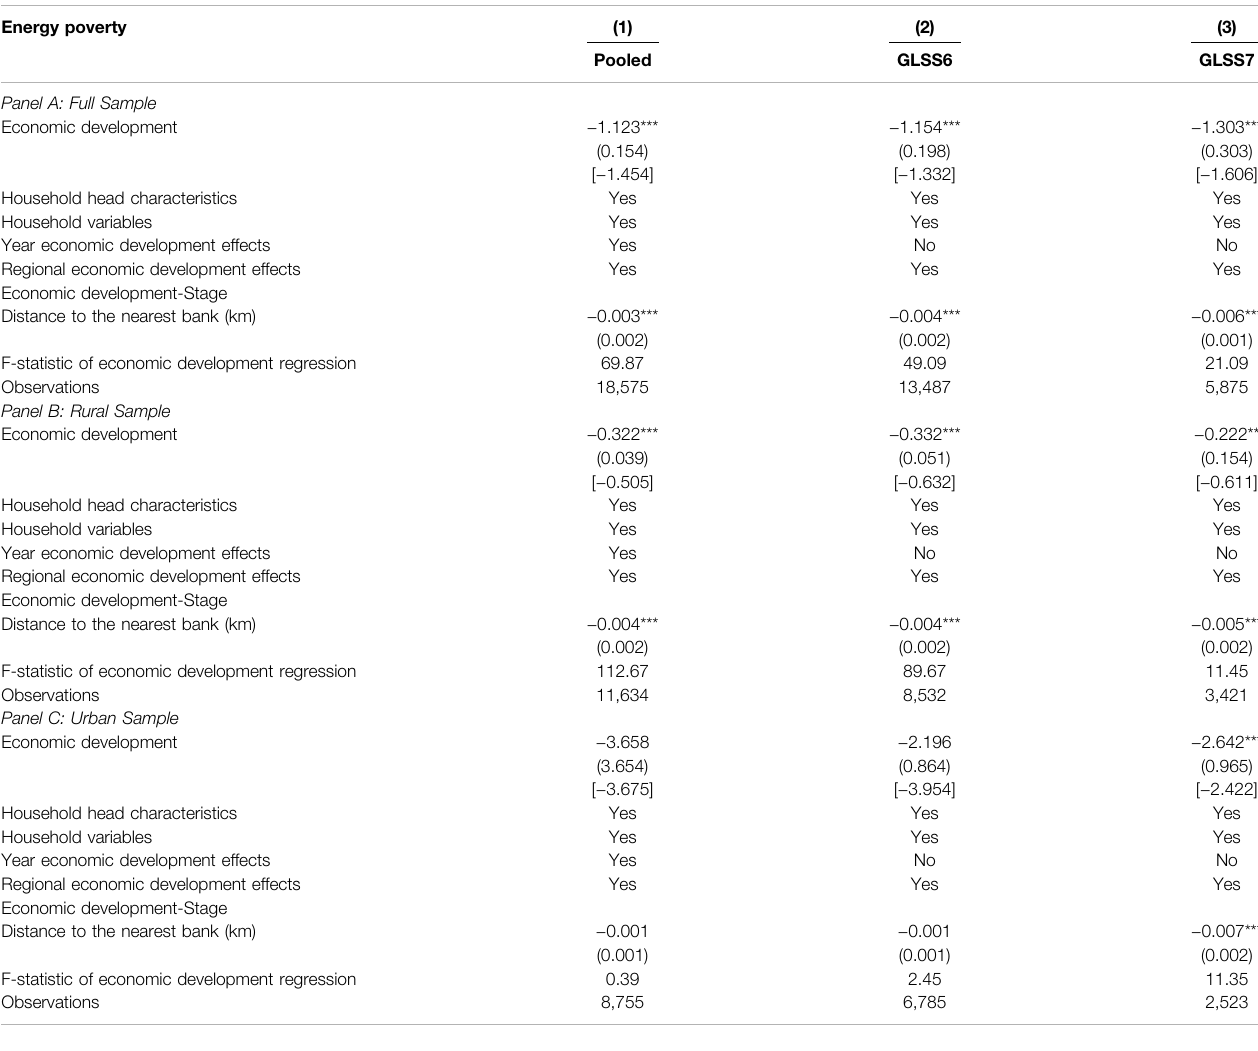
TABLE 4 | Economic development and energy poverty.